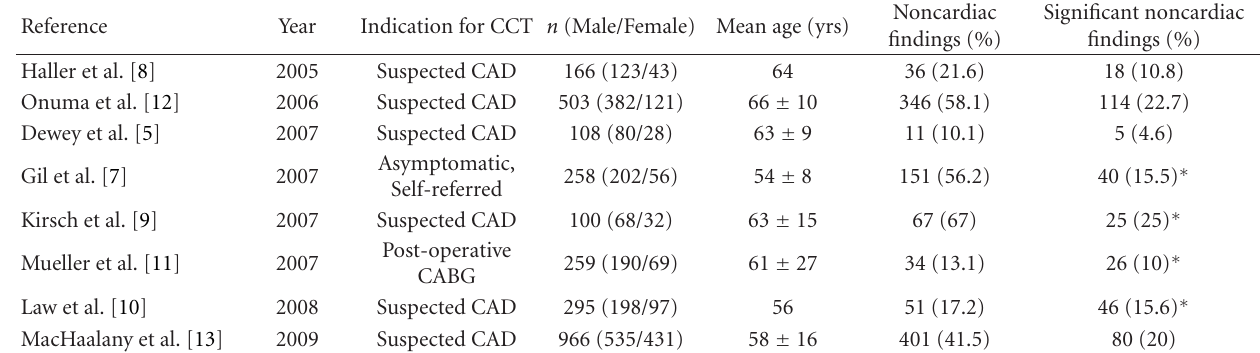
Table 3: CCT studies examining noncardiac